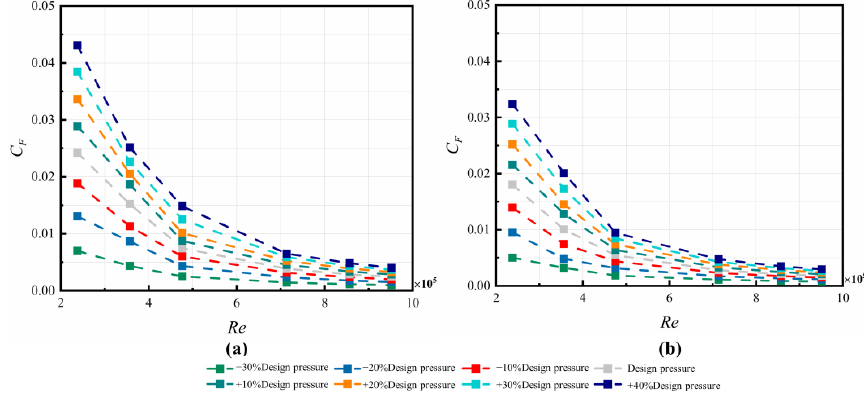
Figure 21. C F distribution in the C1 cavity at different 𝑝 𝑖𝑛,𝑡𝑜𝑡𝑎𝑙 and Re on the ( a ) rotor and ( b ) stator.